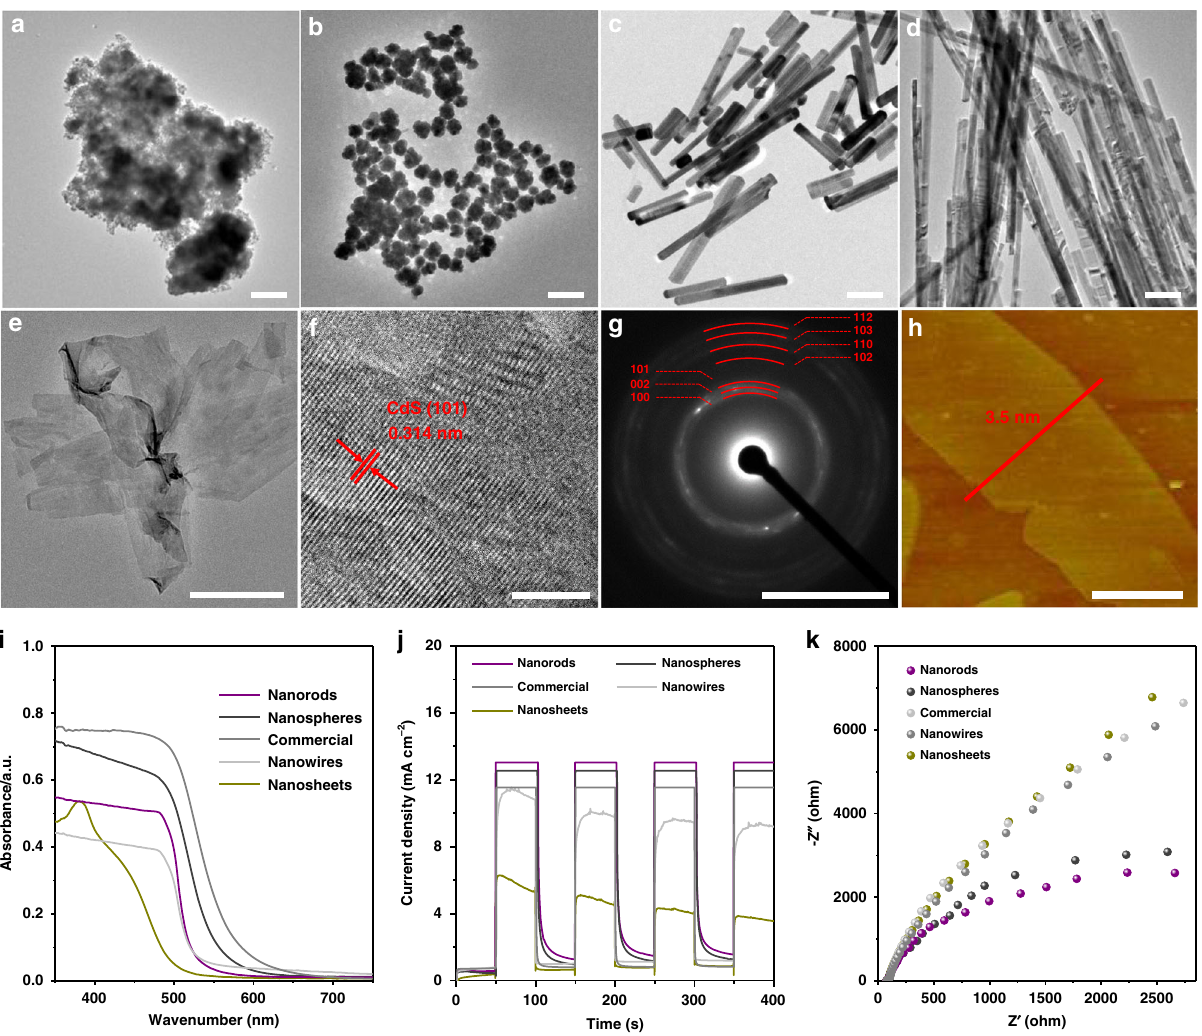
Fig. 3 Characterization of different morphology CdS. TEM image of a commercial CdS. b Nanospheres. c Nanorods. d Nanowires. e Nanosheets. f High- resolution TEM of nanosheets. g Electron diffraction patterns of nanosheets. h AFM images of nanosheets. i UV-Vis spectra. j Photocurrent transient spectra. k Electrochemical impedance spectroscopy (EIS) Nyquist plots. Scale bar: a – e 200 nm; f 5 nm; g 5 nm − 1 ; h 1 μ